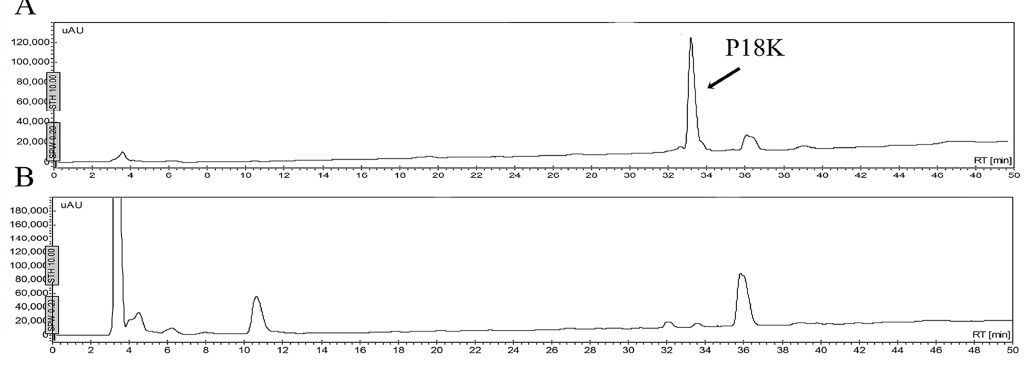
Figure 9. Cont. Figure 9.